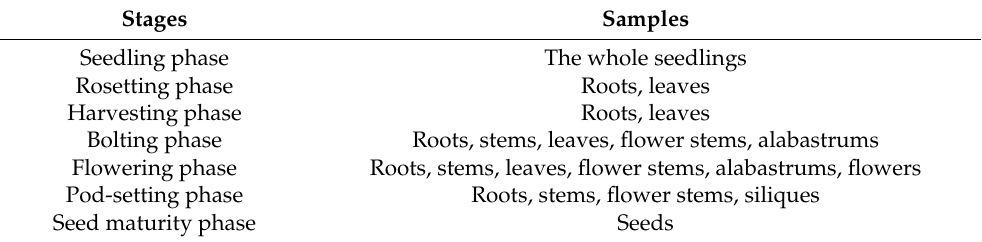
Table 2. Sampling information for leaf mustard JC 18-56 during the whole growth periods.